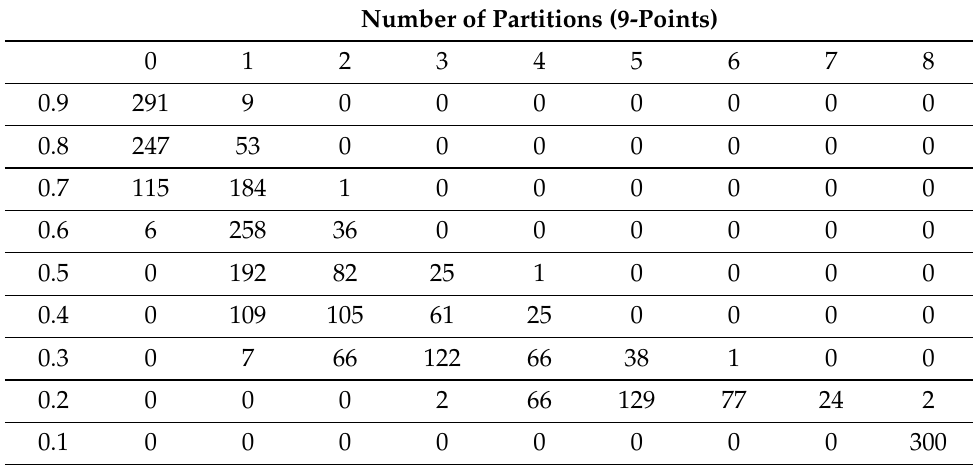
Table 8. Number of partitions using a 9-Likert scale.